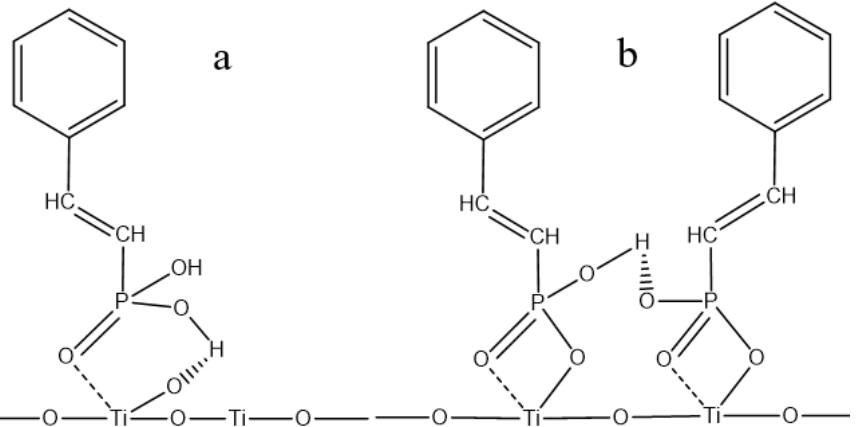
Figure 8. The conjecture of the position of the hydrogen bond after the adsorption of SPA: ( a ) SPA in the formation of hydrogen bonding TiO 2 ; ( b ) SPA molecules to form hydrogen bonds.